Question: What direction does the quantity move in — increasing or decreasing?
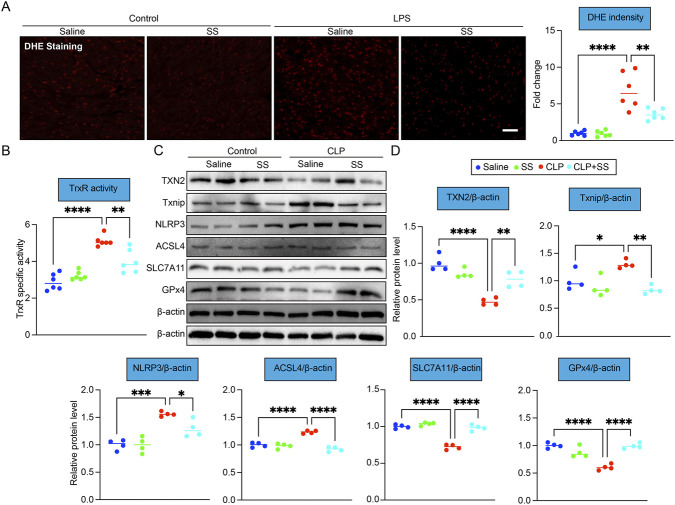
Answer: decreasing